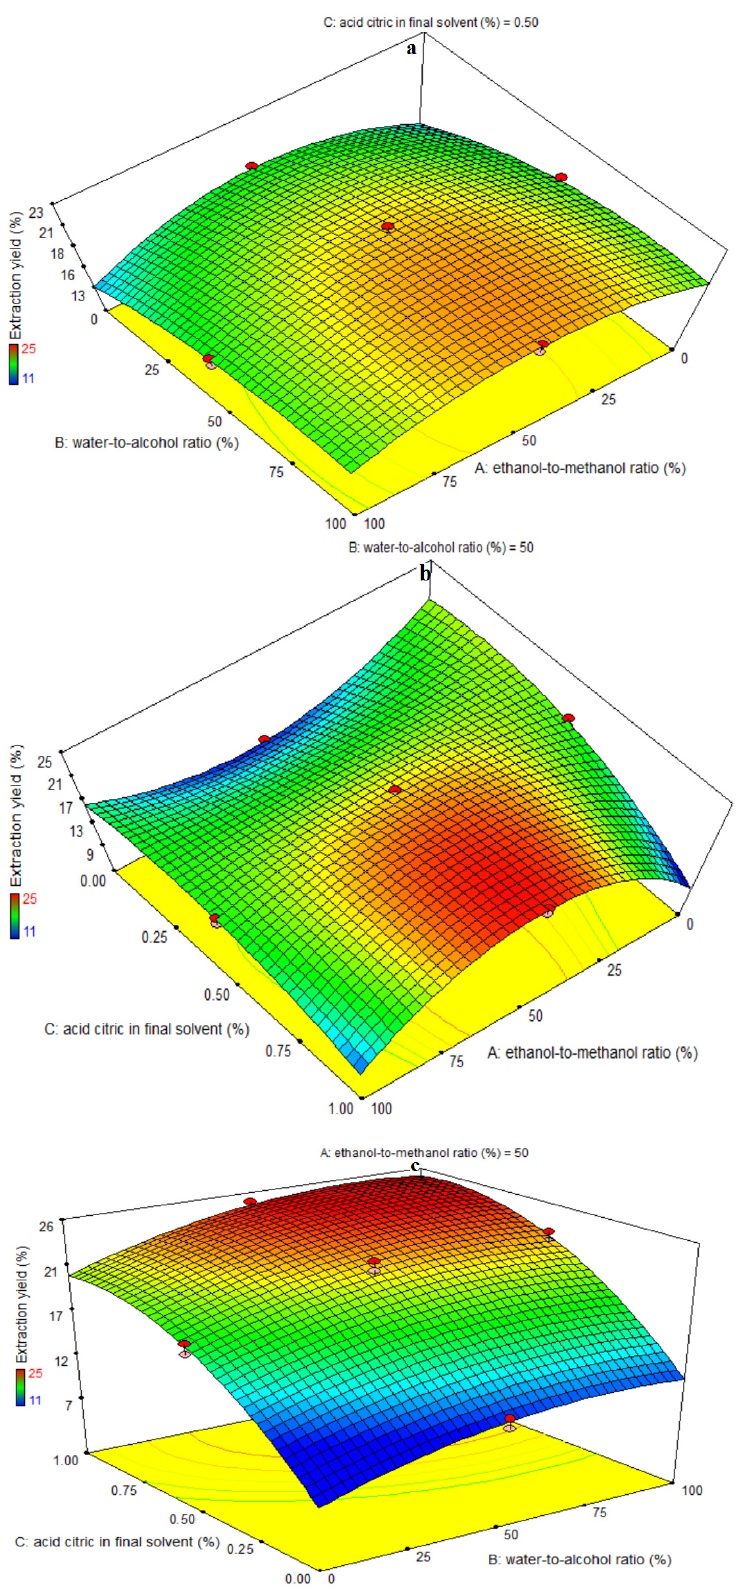
Figure 3. Effects of ethanol-to-methanol ratio (%), water-to-alcohol ratio (%) and citric acid in final solvent (%) on extraction yield (%) in eggplant peel extraction. ( a ): The interaction effect of factors A and B on the intermediate level of factor C., ( b ): The interaction effect of factors A and C on the intermediate level of factor B., and ( c ): The interaction effect of factors B and C on the intermediate level of factor A.